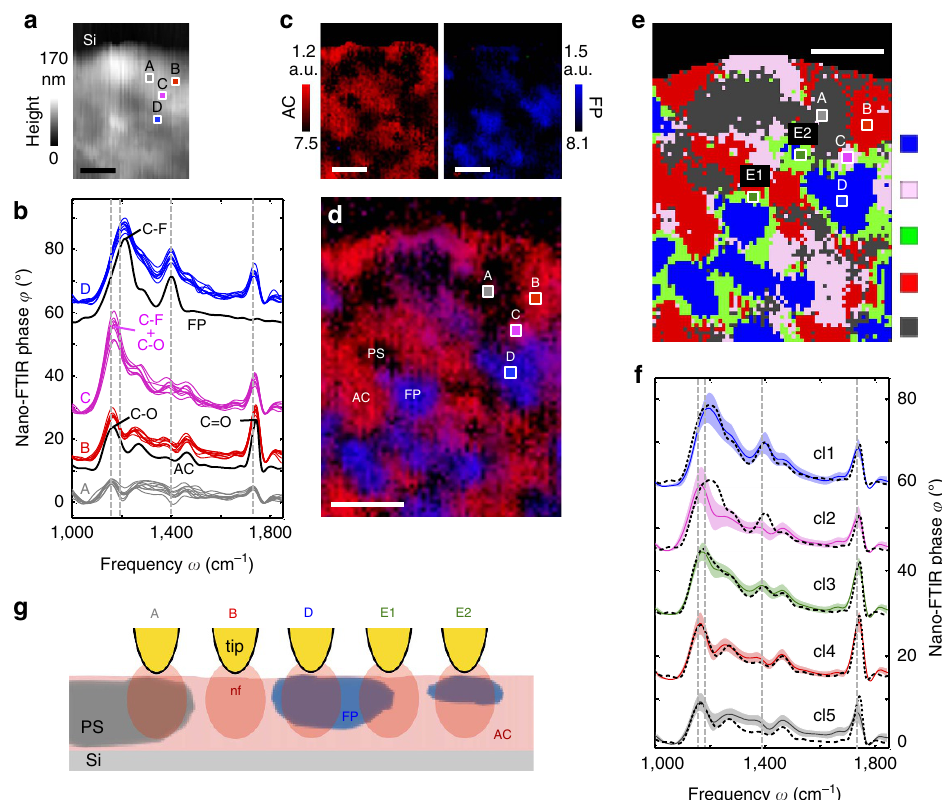
Figure 3 | Chemical nanomapping of polymers. ( a ) Sample topography. Scale bar, 400nm. ( b ) Black curves show nano-FTIR spectra of FP and AC reference samples (44min total acquisition time; 35cm (cid:2) 1 resolution). Coloured curves show the nine nano-FTIR spectra in the areas marked A, B, C and D in a and d , extracted from the data cube shown in Fig. 1d. All spectra are vertically offset. ( c ) Spatial maps of AC and FP obtained by inter-spectral distance mapping. Scale bar, 400nm. ( d ) Compositional map, obtained by superposition of the maps of c . Scale bar, 400nm. ( e ) Cluster map obtained by multivariate data analysis (hierarchical cluster analysis, HCA) showing clusters from cl1 to cl5 (blue, pink, green, red and dark grey, respectively). Scale bar, 400nm. ( f ) Average nano-FTIR spectra and s.d. of clusters cl i (coloured thin and thick lines, respectively). Black dashed spectra show best fits obtained by linear superposition of the pure FP and AC reference nano-FTIR spectra shown in b . ( g ) Schematics of near-field probing at positions A-E2 marked in d and e